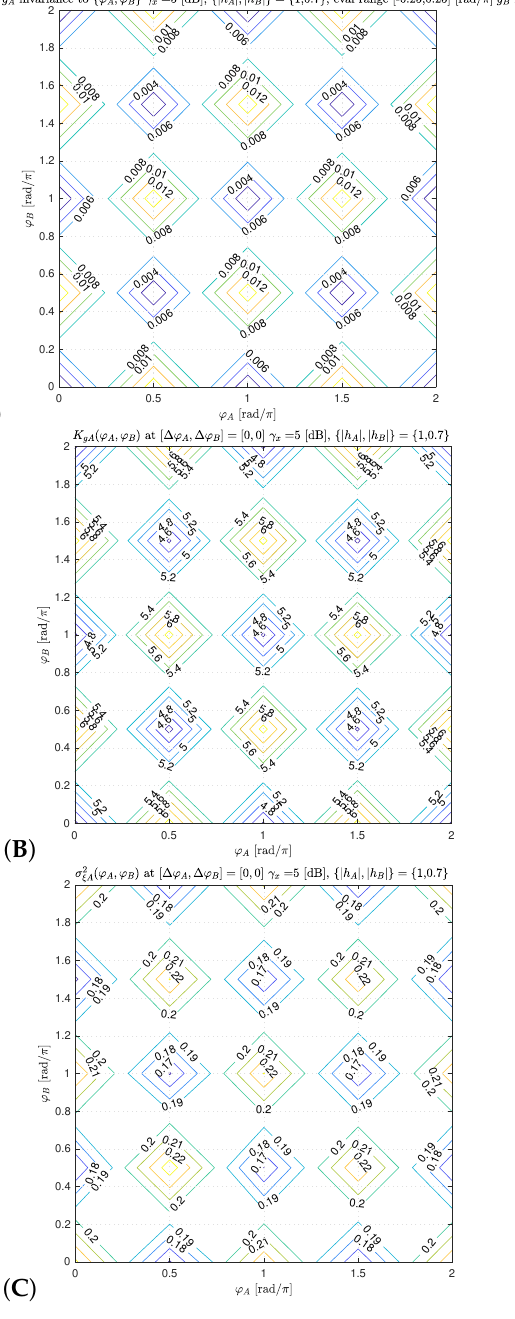
Figure 5. Absolute component phase invariance of ( A ) detector characteristics, ( B ) detector gain and ( C ) equivalent noise variance, γ x = 5